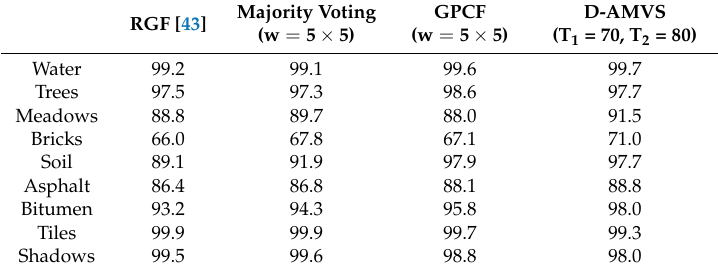
Table 8. Class-specific user accuracy of the Pavia Center image for the different methods.